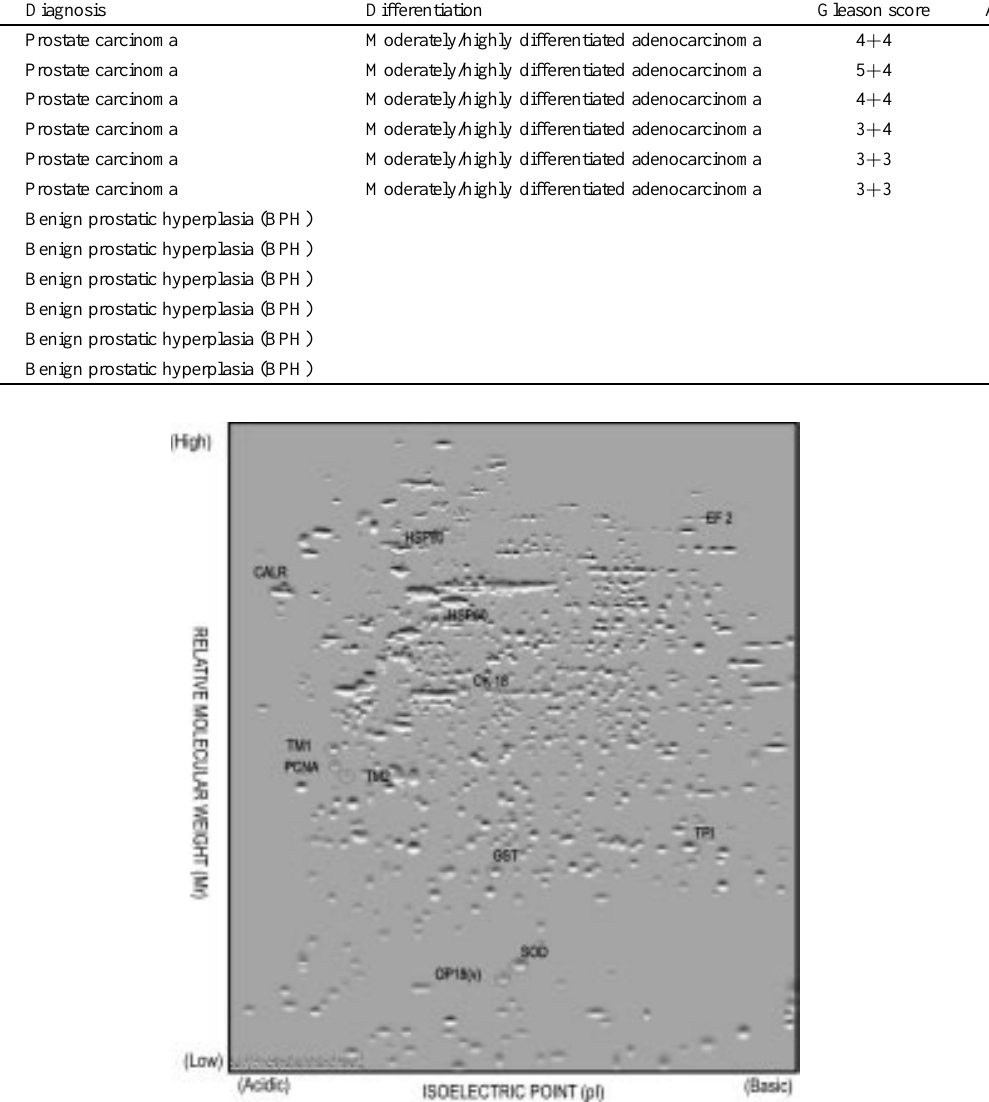
Fig. 1. Two-dimensional gel analysis of cells isolated from benign prostate hyperplasia. Some spots with known identity have been encircled.